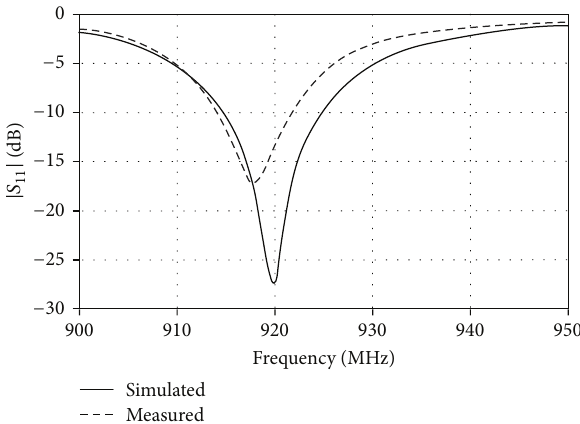
Figure 5: Simulated and measured |𝑆 11 |